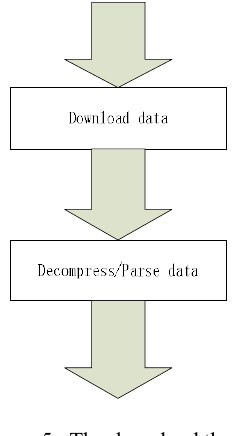
Figure 5. The download thread